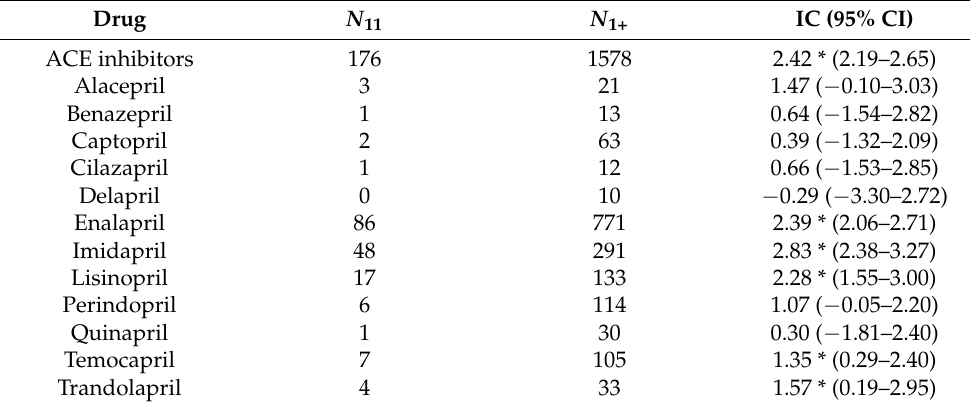
Table 3. The signal scores of each angiotensin-converting enzyme (ACE) inhibitor.